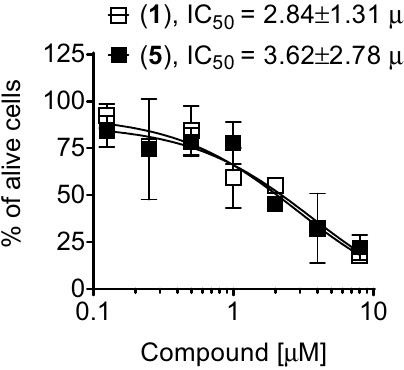
Figure 2. Activity of compounds in 22Rv1 cells determined using trypan blue staining assay. Cells were treated for 48 h. The IC 50 s are represented as mean ± SD.